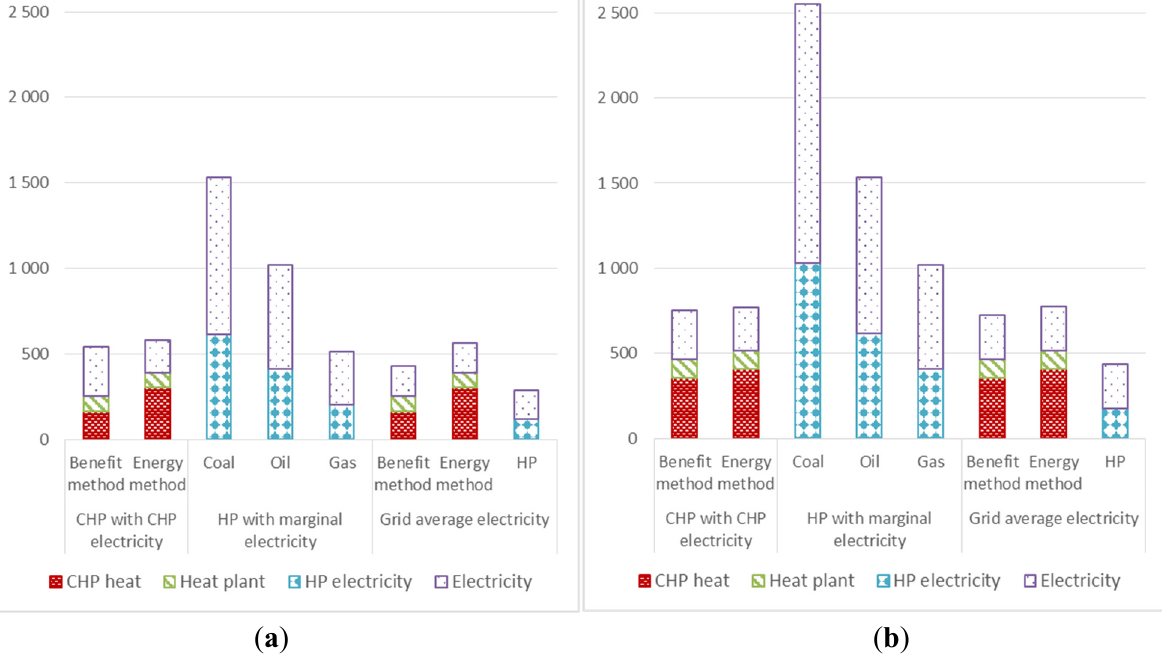
Figure 1. ( a ) The annual GHGs incurred by the Härmälänranta settlement with the lower GHG intensity boundaries (t CO 2 e/a); ( b ) The annual GHGs incurred by the Härmälänranta settlement with the upper GHG intensity boundaries (t CO 2